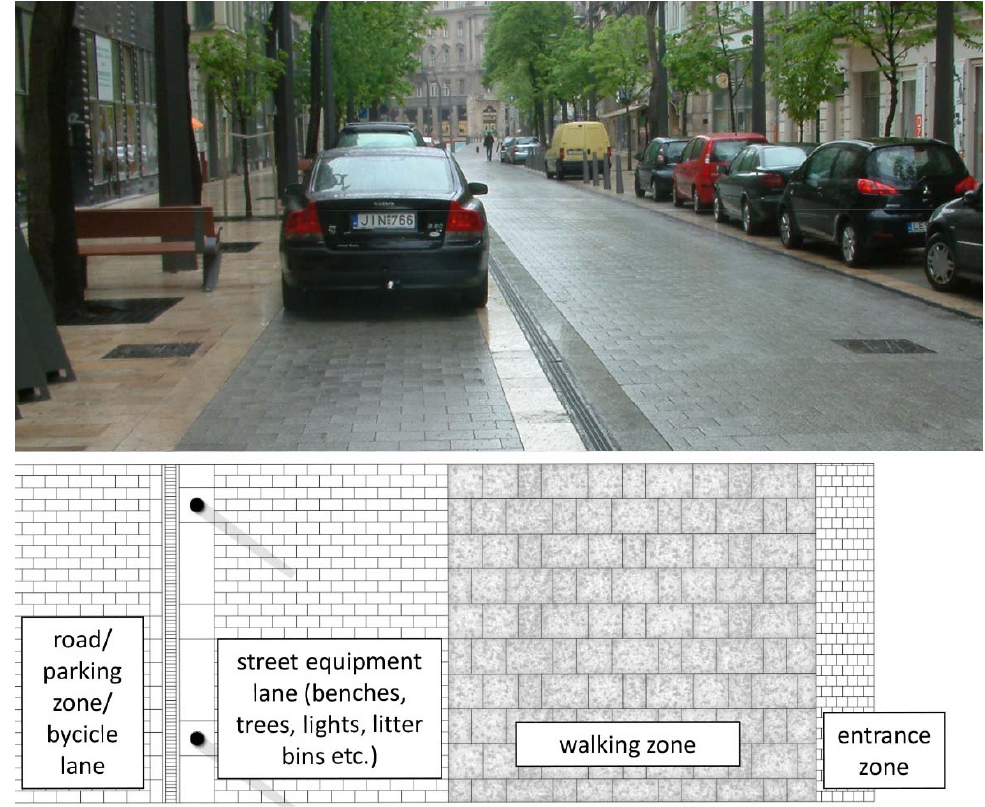
Figure 2. The pavement layout of the High Street—the plan ( below ) and the realised layout ( above ). The stones used are: granite slabs (for the areas serving for vehicle and mixed traffic or parking), limestone slabs (pedestrian and furniture zones), and the combination of the two. (Photos by the authors).